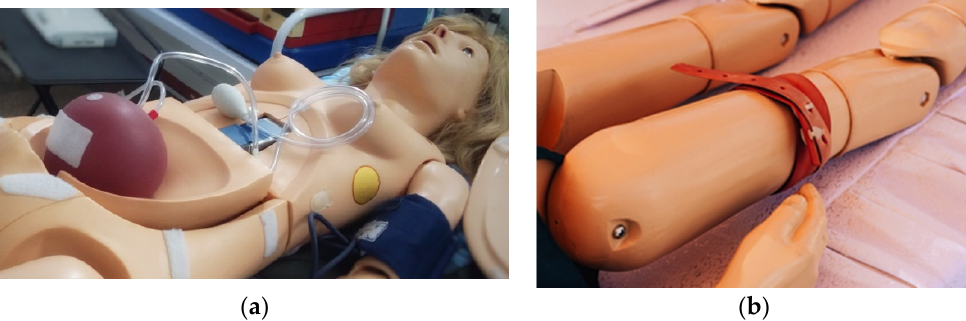
Figure 1. Trauma hemorrhagic simulators. ( a ) Individual bleeding trauma module [25]; ( b ) Lower limb trauma simulator [26].